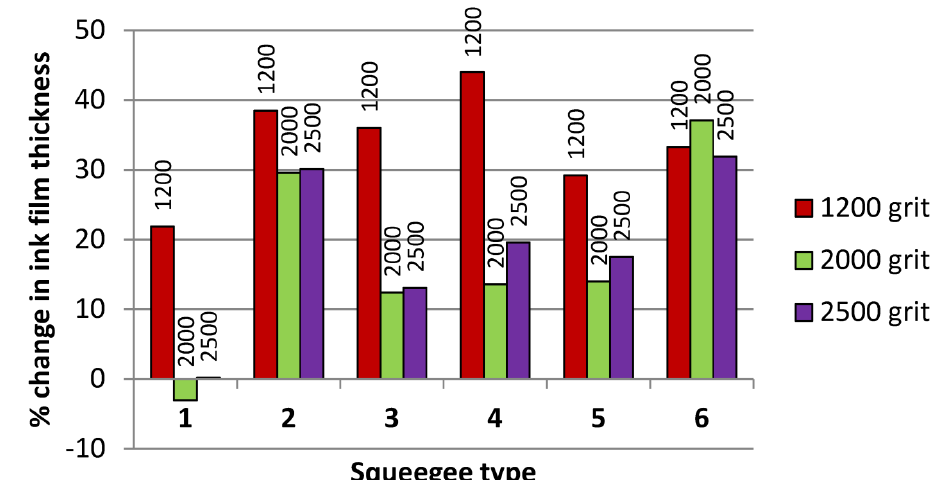
Figure 11. Percentage change in printed ink film thickness as a result of squeegee wear (average for all measured